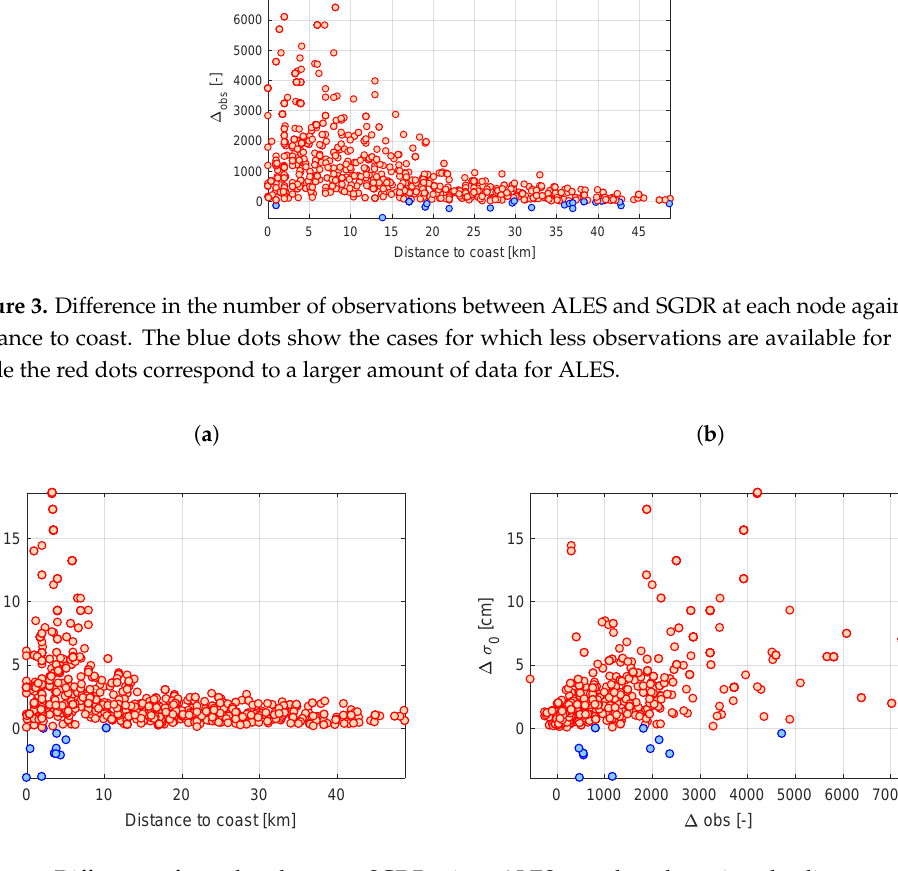
Figure 4. Difference of σ 0 values between SGDR minus ALES at each node against the distance to coast ( a ), and against difference in number of observations between ALES and SGDR ( b